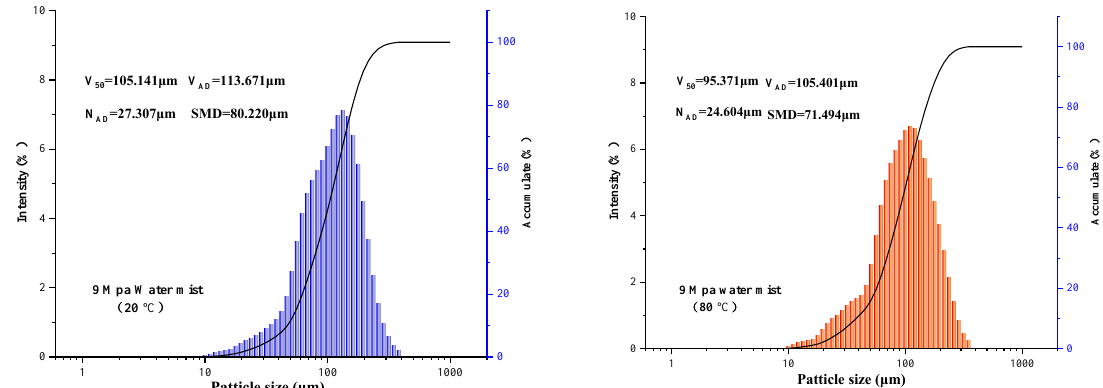
Figure 4. Particle size distribution of 20 °C and 80 °C water mist at 9 MPa .